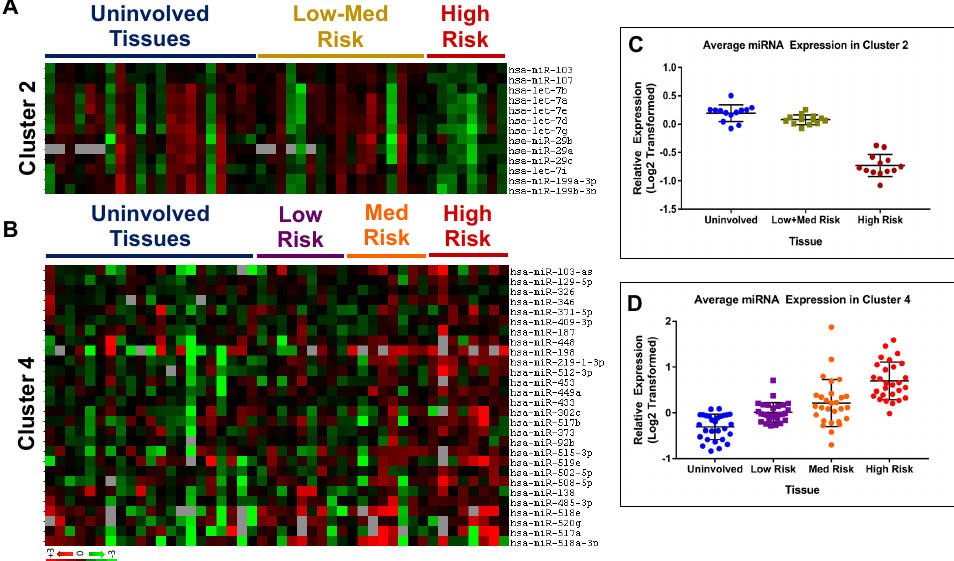
Figure 3. Analysis of clusters 2 and 4 identified from miRNA profiling of prostate tissues. Correlation of miRNA expressions with CAPRA-S risk group. ( A , B ) Heat maps of expression data for miRNAs in clusters 2 ( A ) and 4 ( B ). ( A ) Uninvolved tissue samples (U) grouped under the blue line, low- and medium-risk (L+M) patient tumor samples grouped under the gold line, and high-risk (H) patient tumor samples grouped under the red line. ( B ) Uninvolved tissue samples appear under the blue line, low-risk patient tumor samples are grouped under the purple line, medium are grouped under the orange line, and high-risk patient tumor samples are grouped under the red line. ( C , D ) The average expression value of each miRNA was calculated for uninvolved tissues and tumor tissues grouped by CAPRA-S risk. Values were used to generate dot plots for cluster 2 ( C ) ( p = 0.024 U vs. L+M, 2.14 × 10 − 12 U vs. H, 1.57 × 10 − 10 L+M vs. H) and cluster 4 ( D ) ( p = 1.46 × 10 − 5 U vs. L, 2.60 × 10 − 5 U vs. M, 2.51 × 10 − 14 U vs. H, 0.06 L vs. M, 1.01 × 10 − 9 L vs. H, 0.0002, M vs. H).